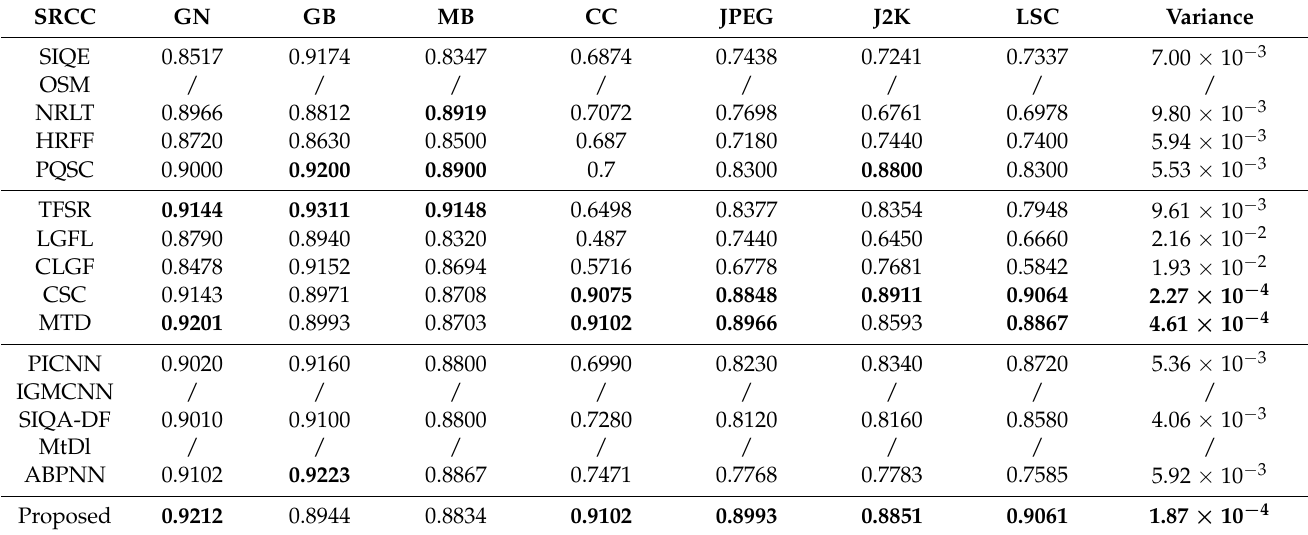
Table 5. SRCC results of different distortion types for the proposed and other methods on